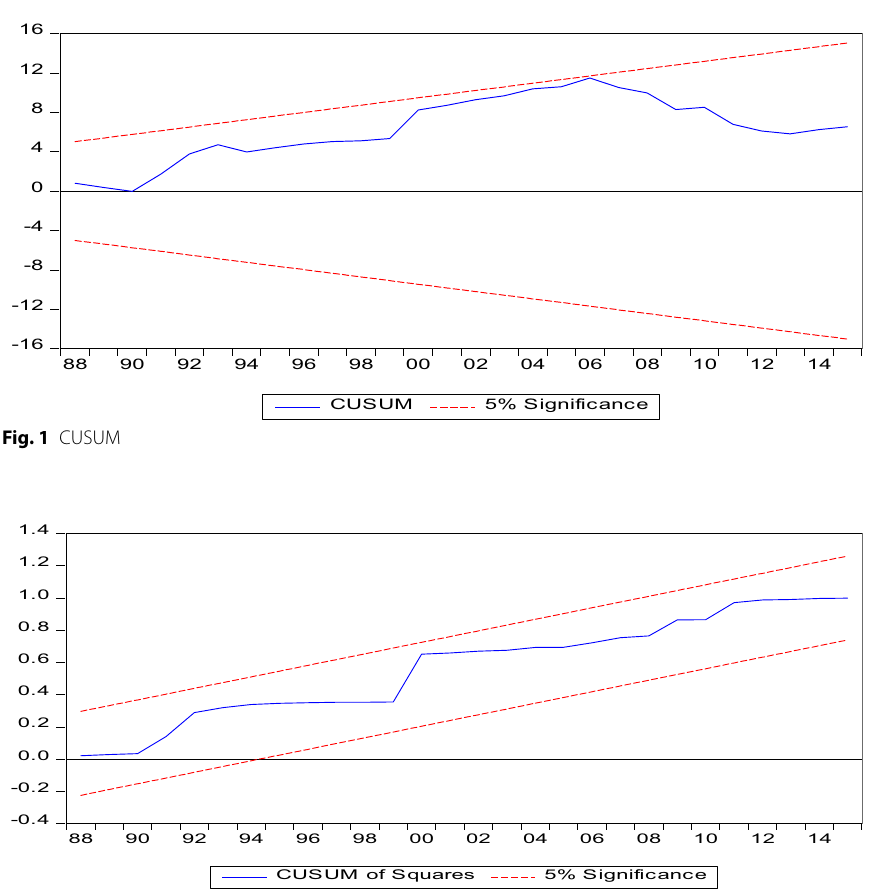
Fig. 2 CUSUM of squares. The straight lines represent critical bounds at 5% significance